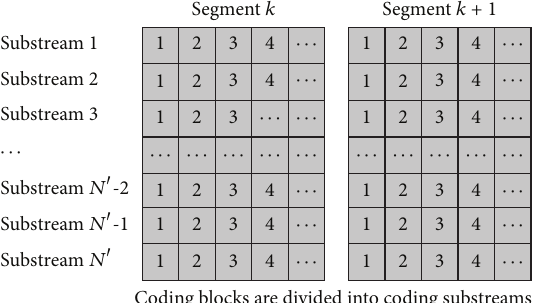
Figure 1: The coding method and the coding